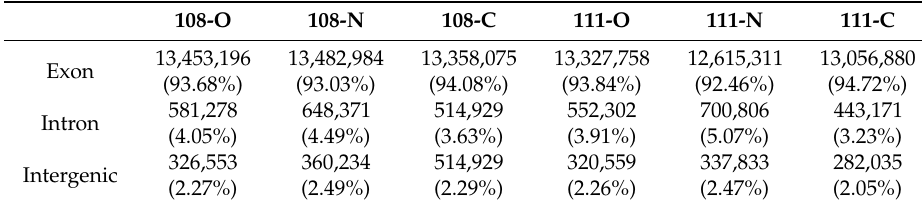
Table 2. Comparison read distribution